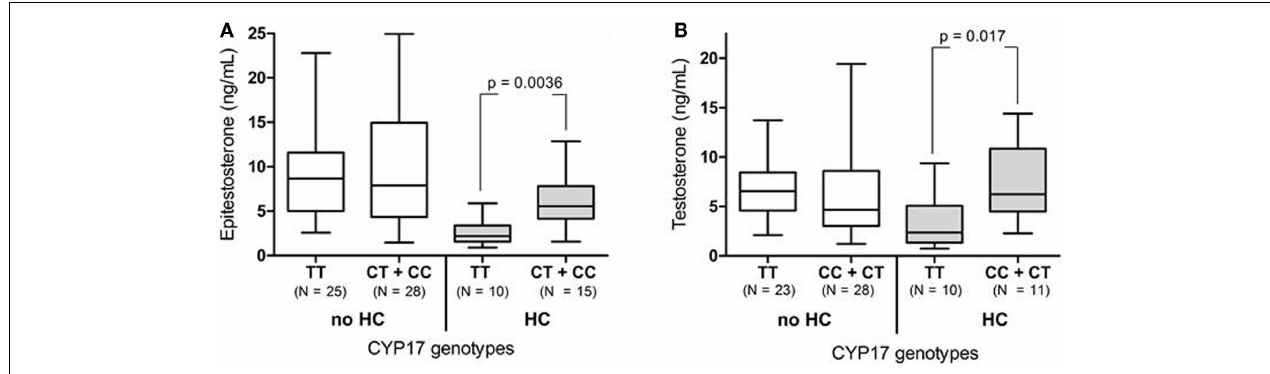
FIGURE 2 | (A) The urinary epitestosterone concentration for elite female athletes divided in CYP17 genotypes and HC use.The CC and CT genotypes were combined to increase statistical power. (B) The urinary testosterone concentrations after removing the UGT2B17 del / del individuals.